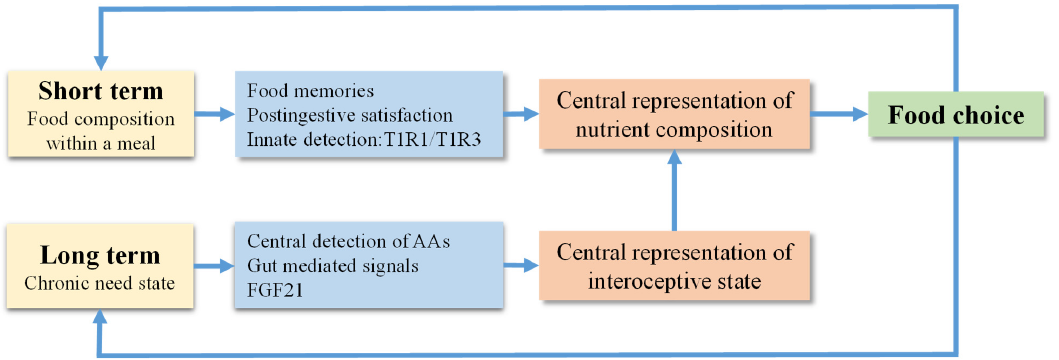
Figure 1. Conceptual mechanism of food choice as an interaction between short-term meal-related cues and long-term signals of the nutritional state. The ability to alter food choice in response to internal nutritional state requires at least two interdependent mechanisms. Within the meal, the animal must sense the nutrient composition of food using sensory cues (visual, gustatory, and/or olfactory inputs), with this information interacting with prior experiences (food memories) to produce a central representation of the nutrient content of a particular food. Separately, the chronic restriction of protein/amino acid availability is signaled via endocrine (possibly FGF21) and/or neural mechanisms, which produce a central representation of interoceptive state. Then, these two central representations interact, such that need state signals shift the value of nutrient-specific cues and/or memories, thereby coordinating adaptive, unconscious shifts in the food preferences that increase the intake of the needed nutrient, in this case protein or essential amino